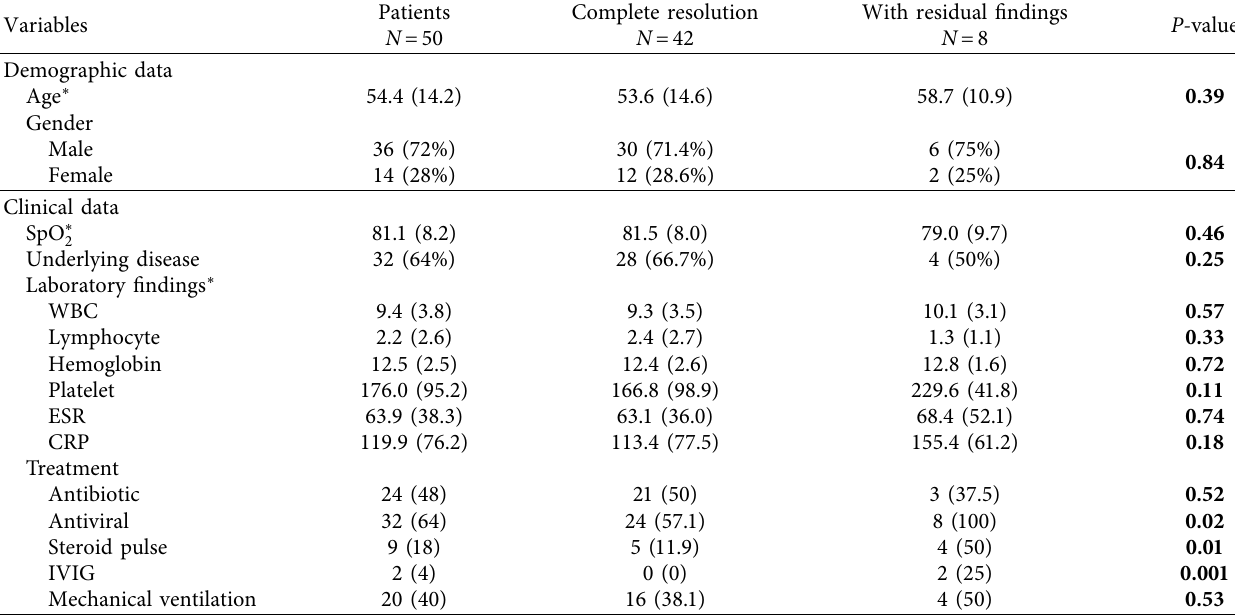
Table 1: Details of demographic and clinical data of patients and diferences between the two groups.